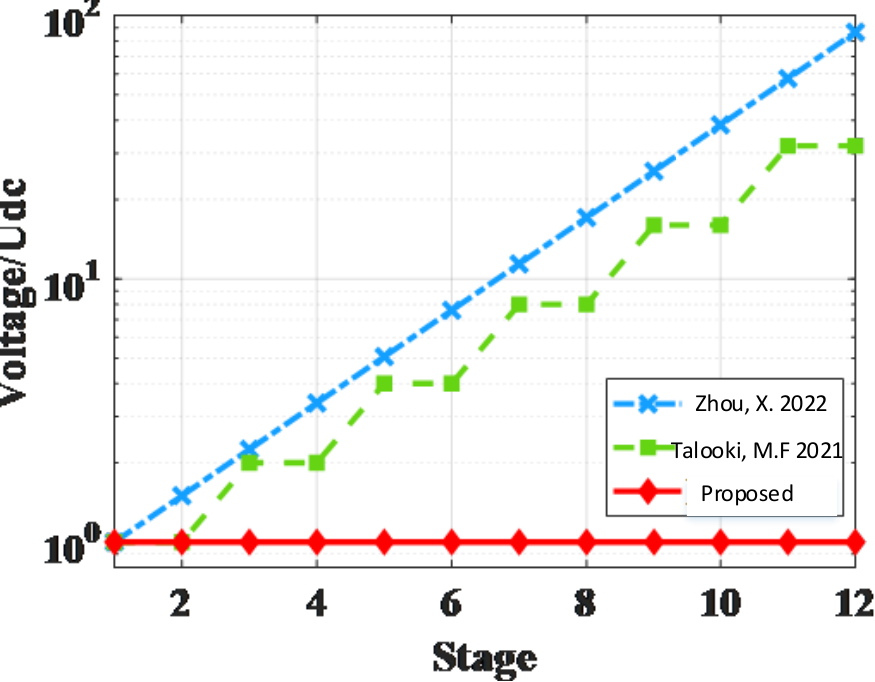
Figure 7. Comparison plots between the literature [23,25] and the module voltage levels in this paper.